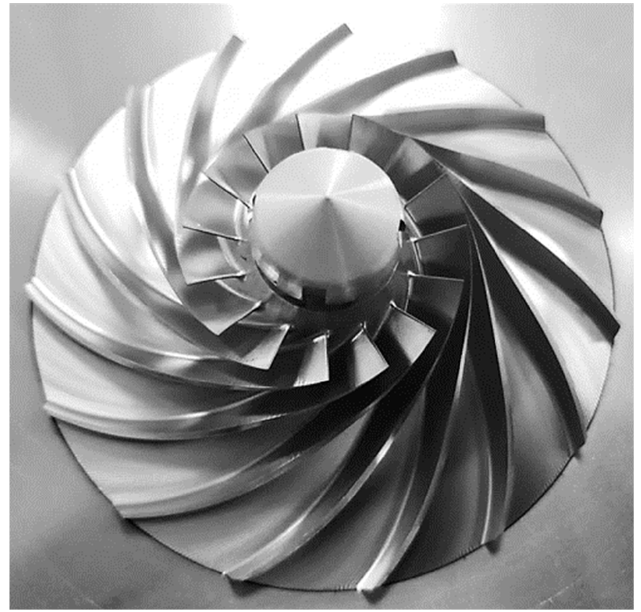
Figure 20. The impeller of single-stage compressor after tests.